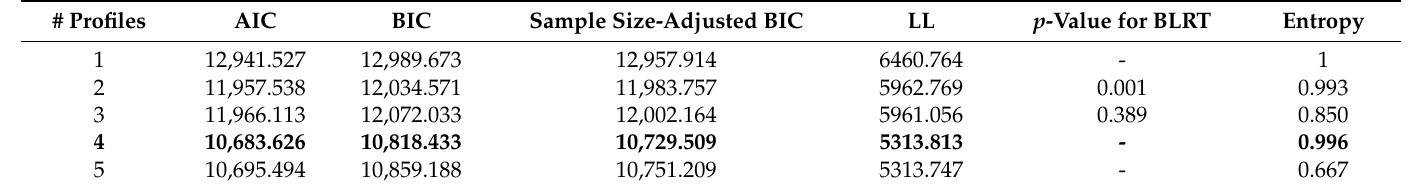
Table 5. Adjustment of comorbidity profiles 1-6 of the different Internet